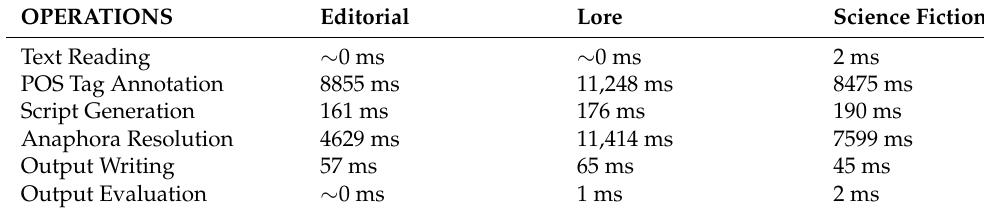
Table 6. Average efficiency per document in milliseconds for the different operations in GEARS.